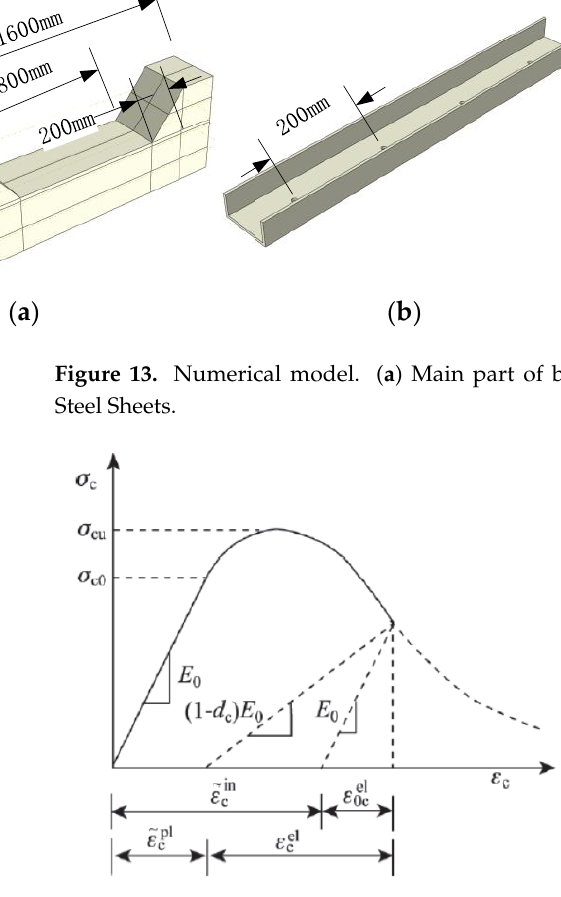
Figure 14. Concrete damage plasticity model.